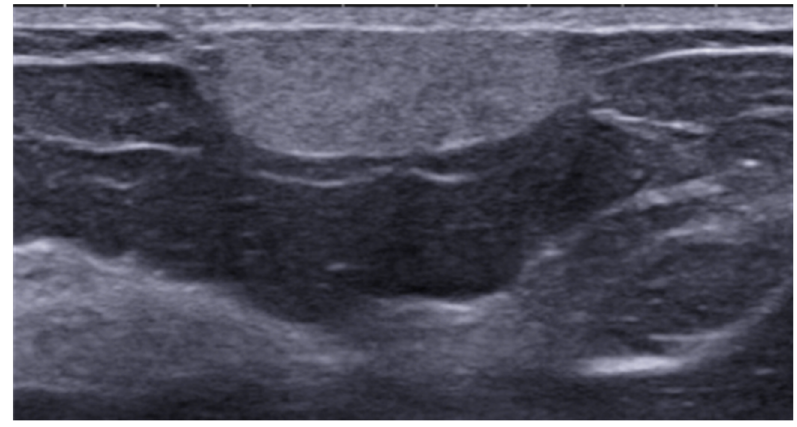
Fig. 2 Angiolipoma. Transverse ultrasound scan of the right breast showing a homogeneous, hyperechoic, oval-shaped subcutaneous mass with circumscribed